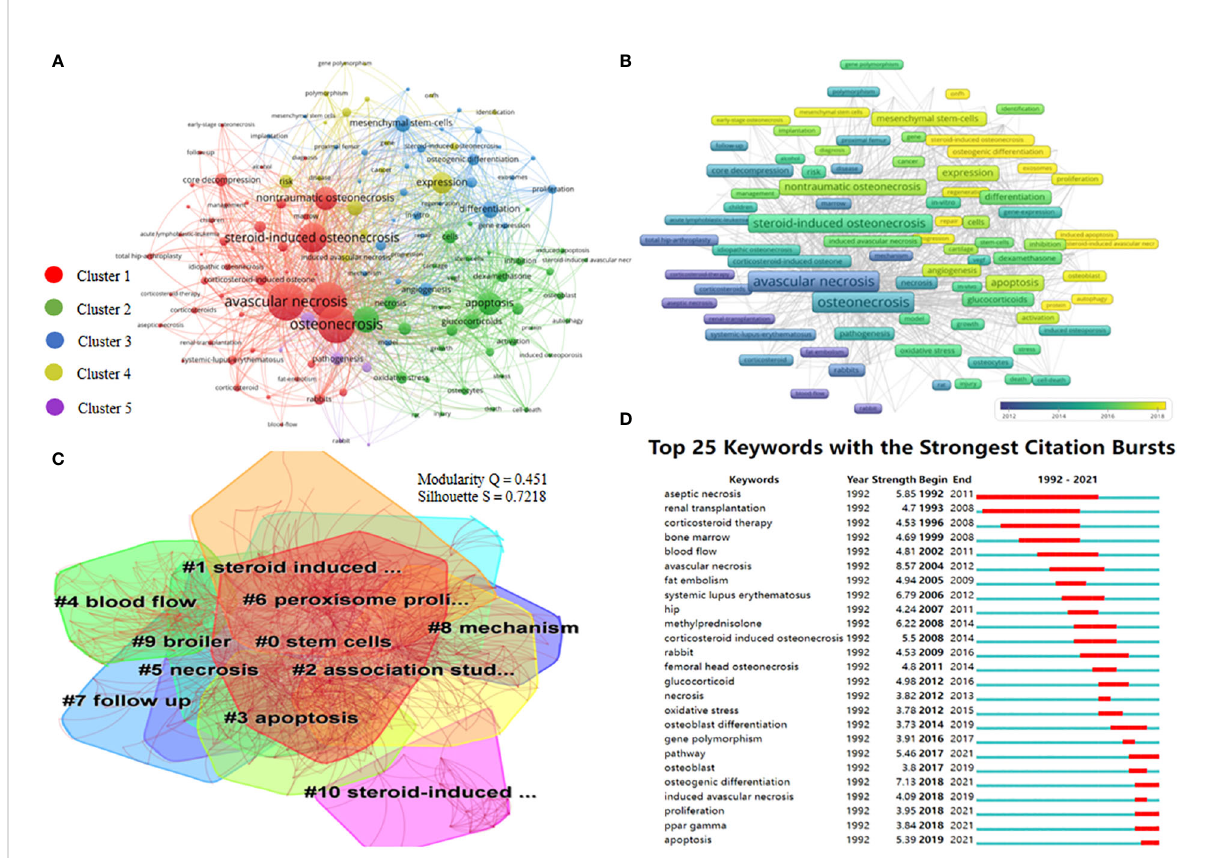
FIGURE 6 Keywords co-occurrence knowledge graph. (A) Keywords co-occurrence network visualization on SONFH from 1992 to 2021. Each node represents one keyword, the node size represented the frequency of a keyword, larger size with a higher frequency. The distance between nodes represents the correlation of two keywords, a closer distance with a stronger association. (B) Keywords co-occurrence overlay visualization on SONFH from 1992 to 2021. The node color represents the average publication year of a keyword. The colors vary from dark blue, turquoise, green, and green-yellow to yellow from far to near with the year. (C) Keywords cluster atlas by CiteSpace. The cluster labels were numbered from 0 to 17. The smaller the number, the more keywords it contained. (D) The top 25 keywords with the strongest citation bursts. The years between “ Begin ” and “ End ” indicate the duration of a keyword burst. The blue line indicates that the keyword has not yet appeared, and the red line indicates that the keyword has a strong in fl